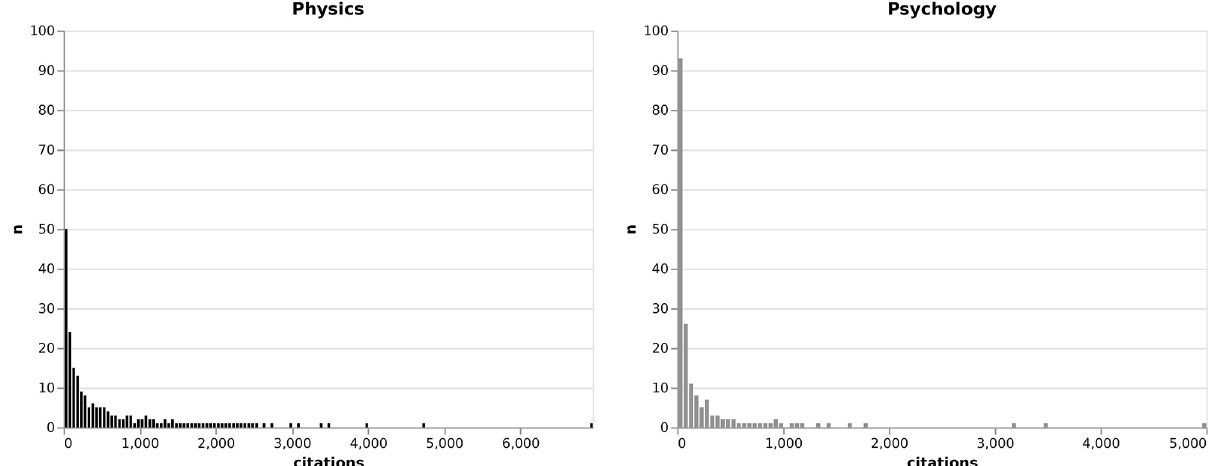
Fig 1. Citation distributions. Number of absolute citations for physics and psychology,